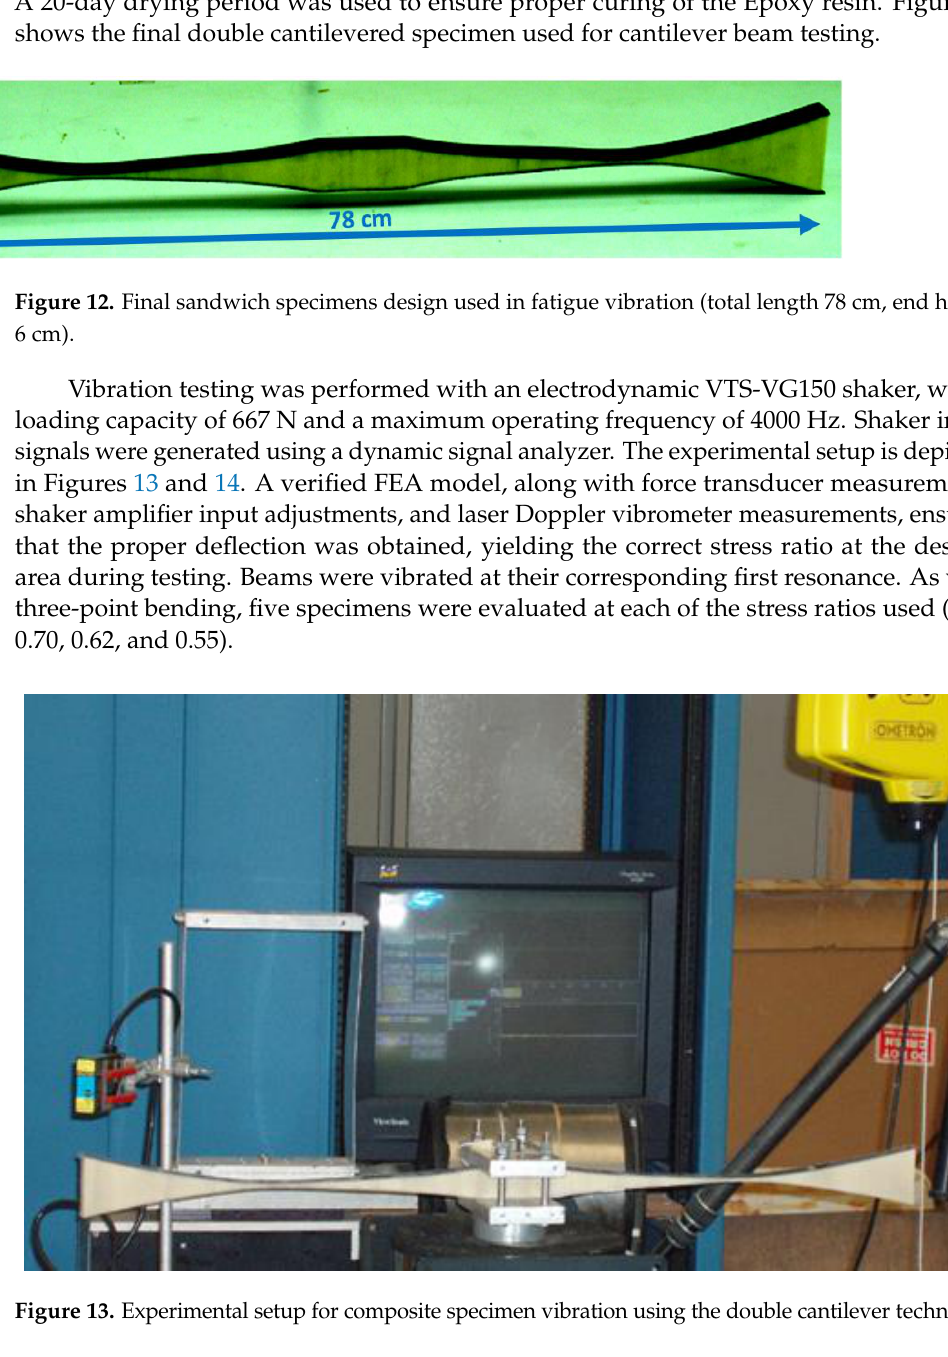
Figure 11. Material MTS 810 test system.